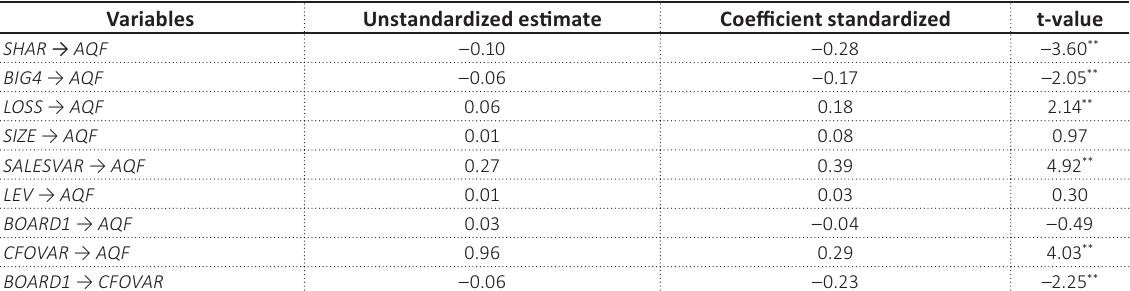
Source: Data processed with